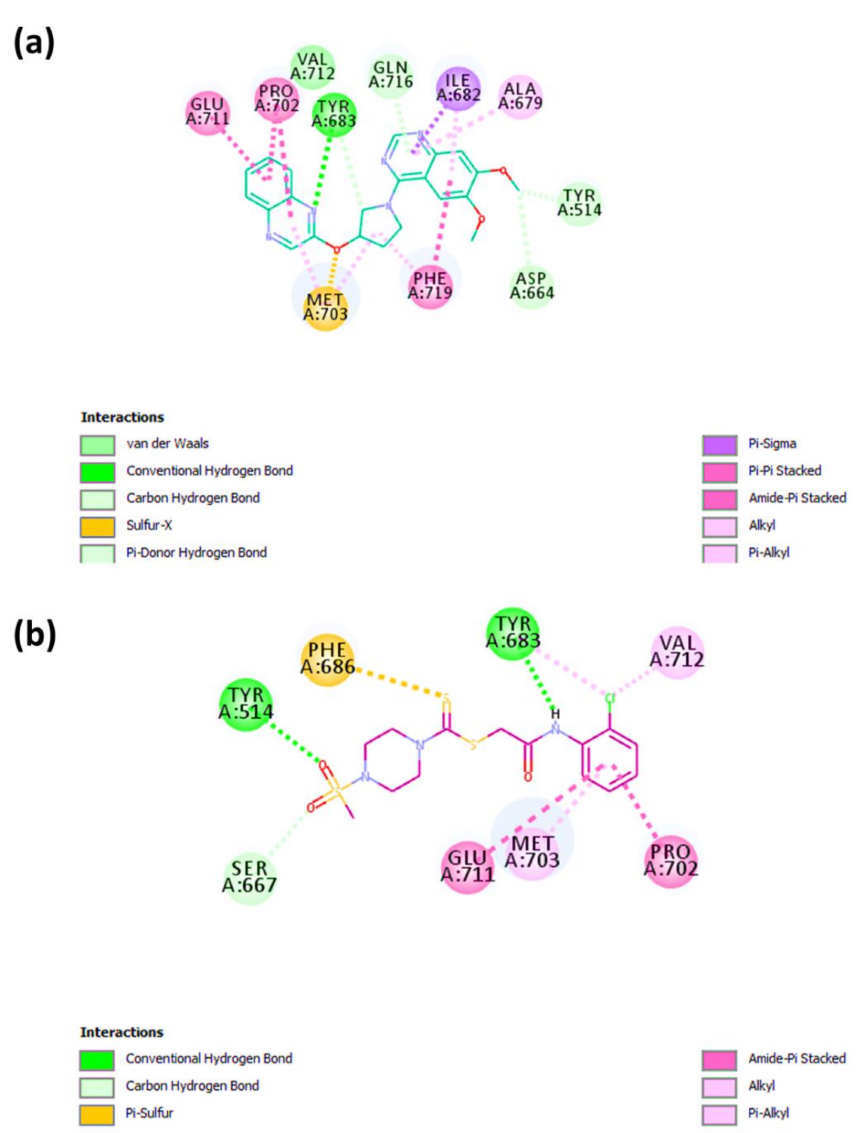
Figure 8. The Interaction behavior of ligands within the active site of PDE10A; ( a ) a 2D representation of PQ10 and ( b ) compound 5b interacting with the PDE10A catalytic residues colored by type of